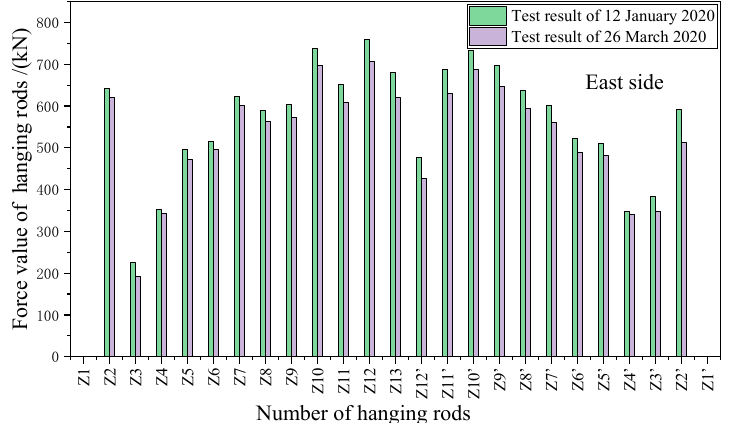
Figure 37. Measured force value of the main arch hanging rods.